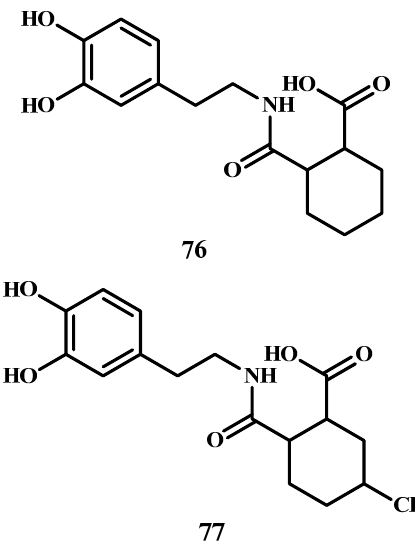
Figure 14. Chemical structures of DA prodrugs 76 and 77 .